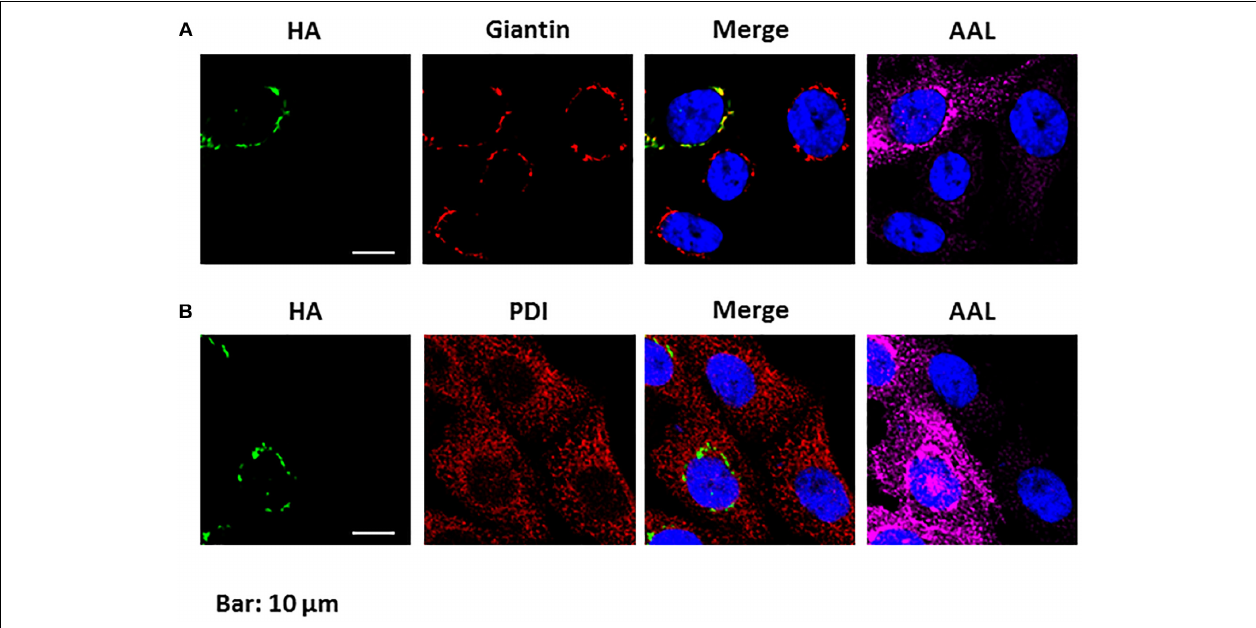
FIGURE 3 | Phaeodactylum tricornutum GFT is localized in the Golgi apparatus and is able to rescue protein fucosylation in CHO-gmt5 cells. (A) Immunolabelling of HA-tagged PtGFT; Giantin and affinostaining with AAL of CHO-gmt5 cells expressing HA-tagged PtGFT. The merge image between the immunolabelling of HA-tagged PtGFT and the Giantin shows the co-localization of both proteins expressed in the CHO-gmt5 cells. (B) Immunolabelling of HA-tagged PtGFT and the PDI ER resident protein, and affinostaining with AAL of CHO-gmt5 cells expressing HA-tagged PtGFT. Note that only CHO cells expressing HA-tagged PtGFT exhibit an AAL staining. Hoechst: nucleus labeling of living CHO cells. The indicated scale bar is 10 µ m for all the images of the figure.